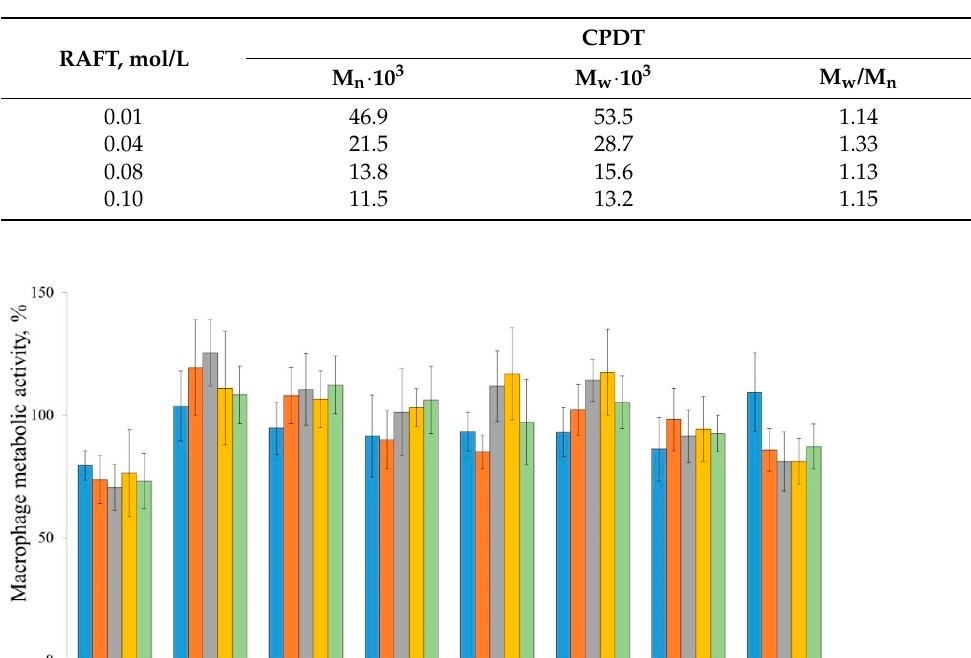
Table 2. Molecular weight characteristics of polyTBMA synthesized in the presence of CPDT, AIBN = 0.002 mol/L, T = 70 °C. RAFT], mol/L